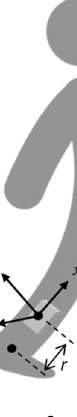
Figure 3. Configuration of the IMUs. Two IMUs are attached to the shank position right above the malleolus at a distance of r . The axes x , y , z are the coordinate system of the IMU, where the z -axis is perpendicular to the sagittal plane formed by the y and z -axes.